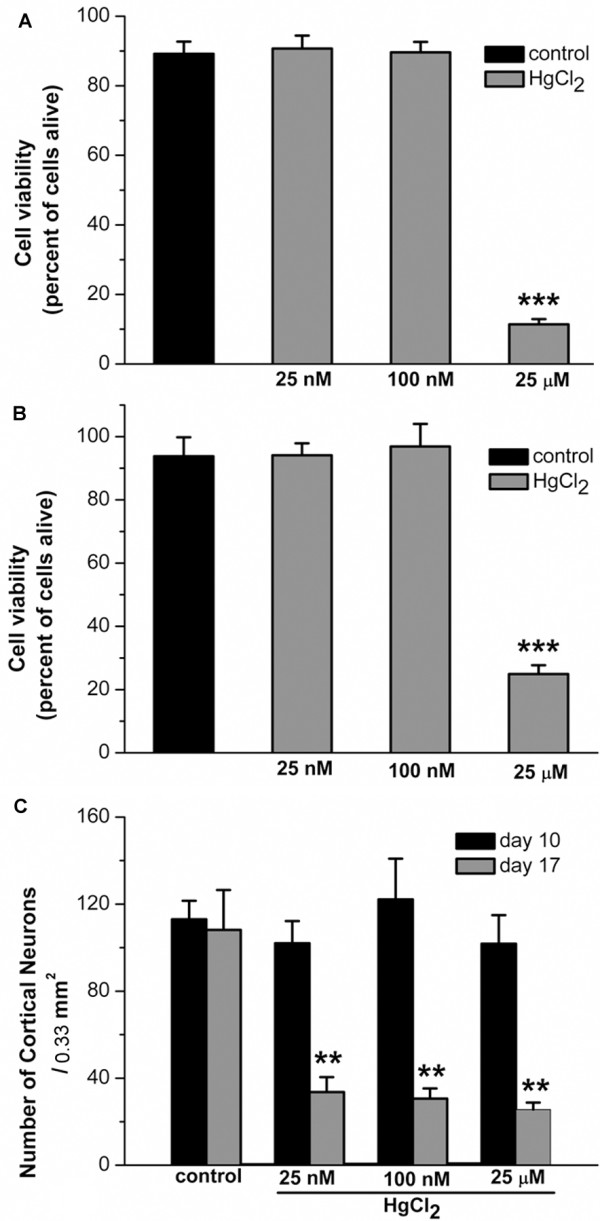
Statistical data showing the acute and chronic effects of HgCl2 on cell viability of developing and mature cortical network. A. To evaluate the effect of HgCl2 on neurite initiation and network formation during the early stage of neuronal development, rat cortical cells were cultured in the absence (control) or presence of HgCl2, at 25 nM, 100 nM, and 25 μM, for 3 days. Cell viability/cytotoxicology assay were performed on day 3. The number of live and dead cells in randomly chosen areas of 1 mm2 was counted. The percentage of live cells is presented in the bar graph. These data show that cultures in the presence of HgCl2 at 25 μM, but not 25 or 100 nM, exhibited significant reduction of cell viability. B. To evaluate the acute effect (< 24 hrs) of HgCl2 exposure on the newly developed network, 4 day old cortical cultures were exposed to HgCl2, at 25 nM, 100 nM, and 25 μM, for 16 to 24 hrs. Subsequent live/dead cell assay showed that acute exposure to higher concentration of HgCl2 at 25 μM significantly reduced the cell viability. C. To evaluate the chronic effect (7 days) of HgCl2 exposure on the neuronal network, cells were grown for 10 days and were maintained for another 7 days in the absence or presence of HgCl2. Phase contrast images of neurons in the same area of 0.33 mm2 were taken on day 10 and day 17. The statistic data show that the numbers of neurons were significantly reduced by exposure to HgCl2 for 7 days at all concentrations examined. Statistical significance was determined using ANOVA (A &B) and Student’s paired t-test (C). Post hoc analysis was conducted using Tukey’s test. ** P < 0.01. *** P < 0.001. Error bars indicate SEM for all figures.